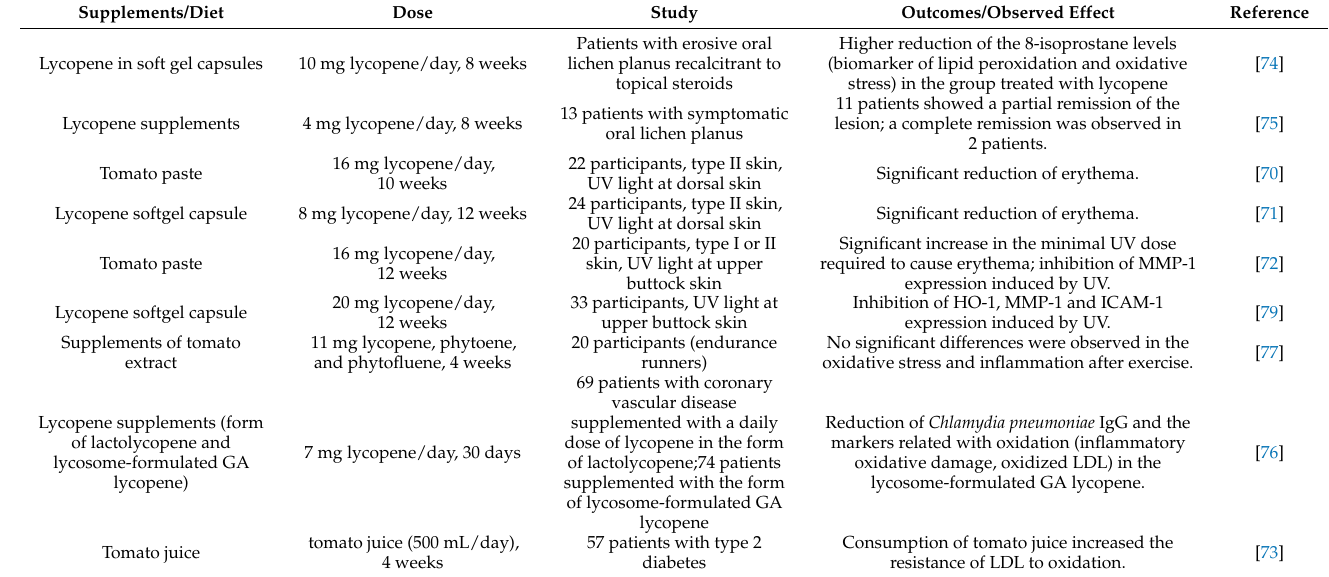
Table 2. Clinical studies to assess the anti-inflammatory properties of